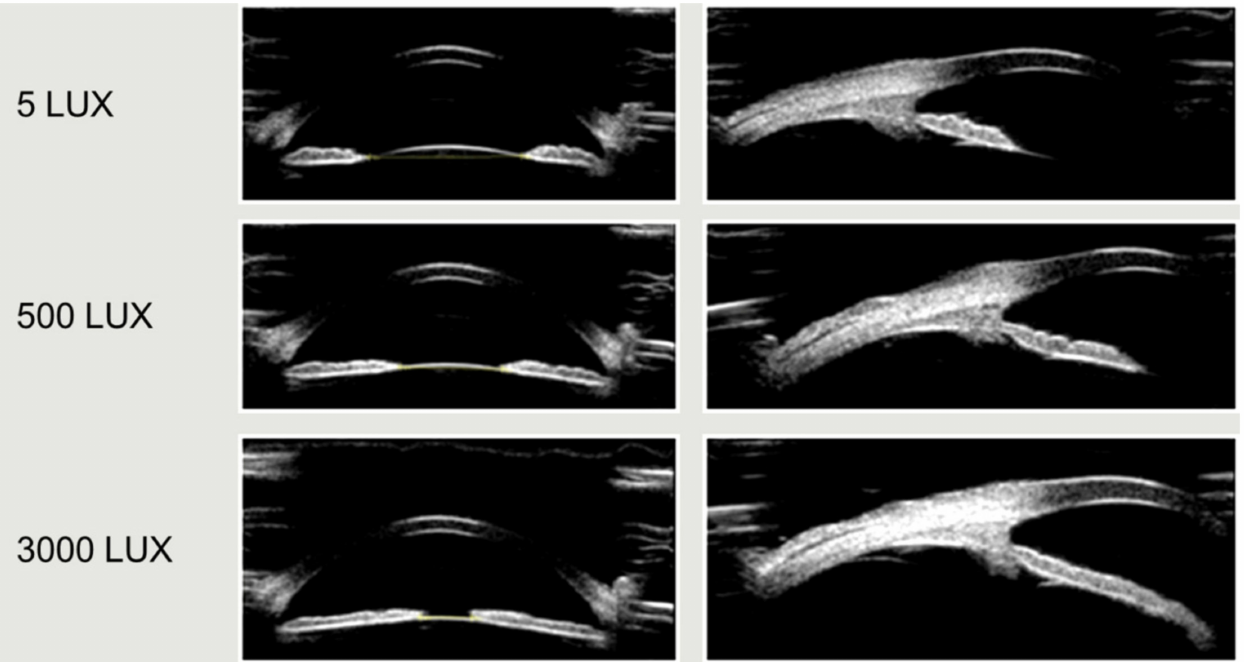
Figure 4. UBM image samples of the anterior segment of a subject’s eye under illuminations of 5500 and 3000 lux, respectively. The pupil shrinks significantly as the light